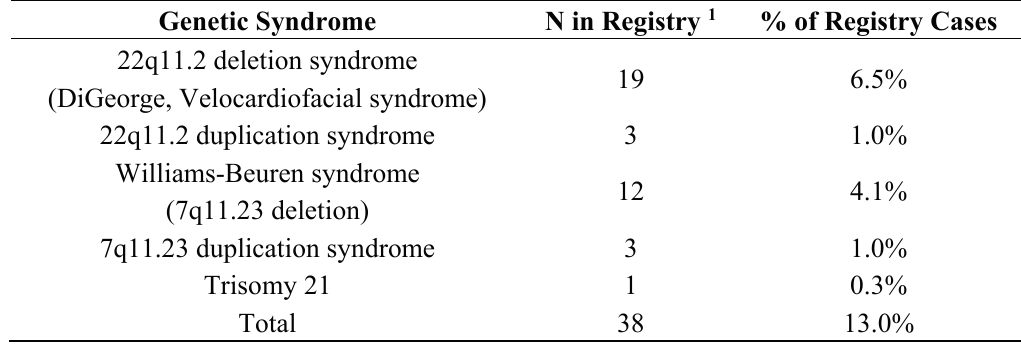
Table 4. Prevalence of Common Genetic Syndromes with CVM in Registry